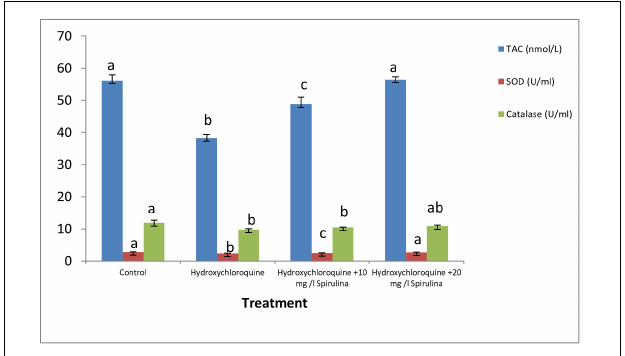
FIGURE 1 | Effect of hydroxychloroquine (HCQ) exposure for 15 days on antioxidant parameters of the African catfish ( Clarias gariepinus ) and treatment with SP (in 10 and 20 mg l - 1 water). Bars with different superscript letters for each parameters are significantly different ( P <